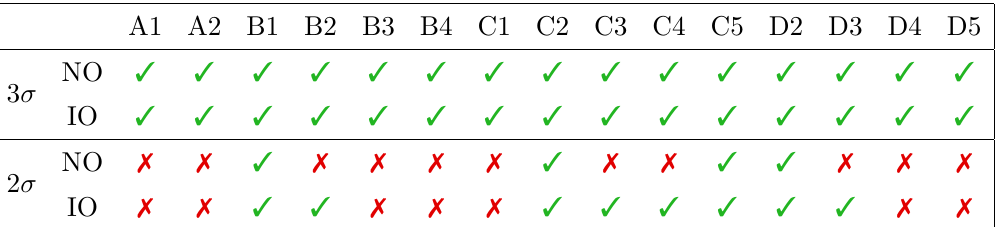
Table 6 . The same as in table 5, but for G e = Z g e In this case the magnitude of the (cid:12)xed element is 1 = 2.